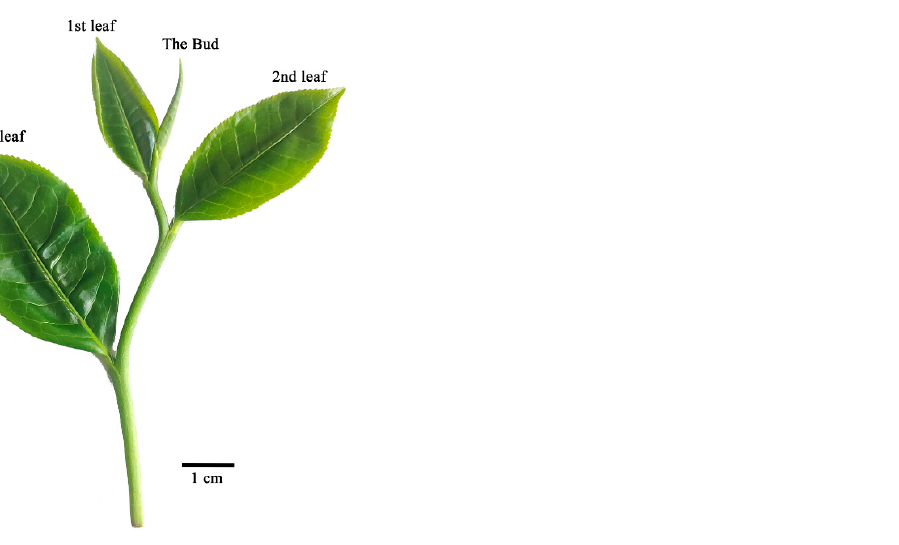
Figure 1. Photograph of the tea shoot sample. The samples taken for the analysis are indicated. The volatile compounds were extracted from the leaves and analyzed with a solid- phase microextraction (SPME)-headspace (HS)/gas chromatograph–mass spectrometer (GC–MS) (Lin et al., 2012). Tissue samples were extracted at 30 °C for 45 min with an SPME fiber coated with divinylbenzene/carboxen/polydimethylsiloxane (DVB/CAR/PDMS). The fiber was immediately inserted into the GC/MS (Agilent 7890A and Agilent 5975C XL EI/CI instruments, respectively) with splitless column effluent. The metabolites were separated using an HP-5MS column (30 m × 250 m × 0.25 m) with helium as the carrier gas, at a flow rate of 1 mL/min.